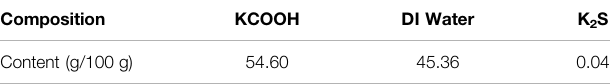
TABLE 2 | Chemical composition of formation water.